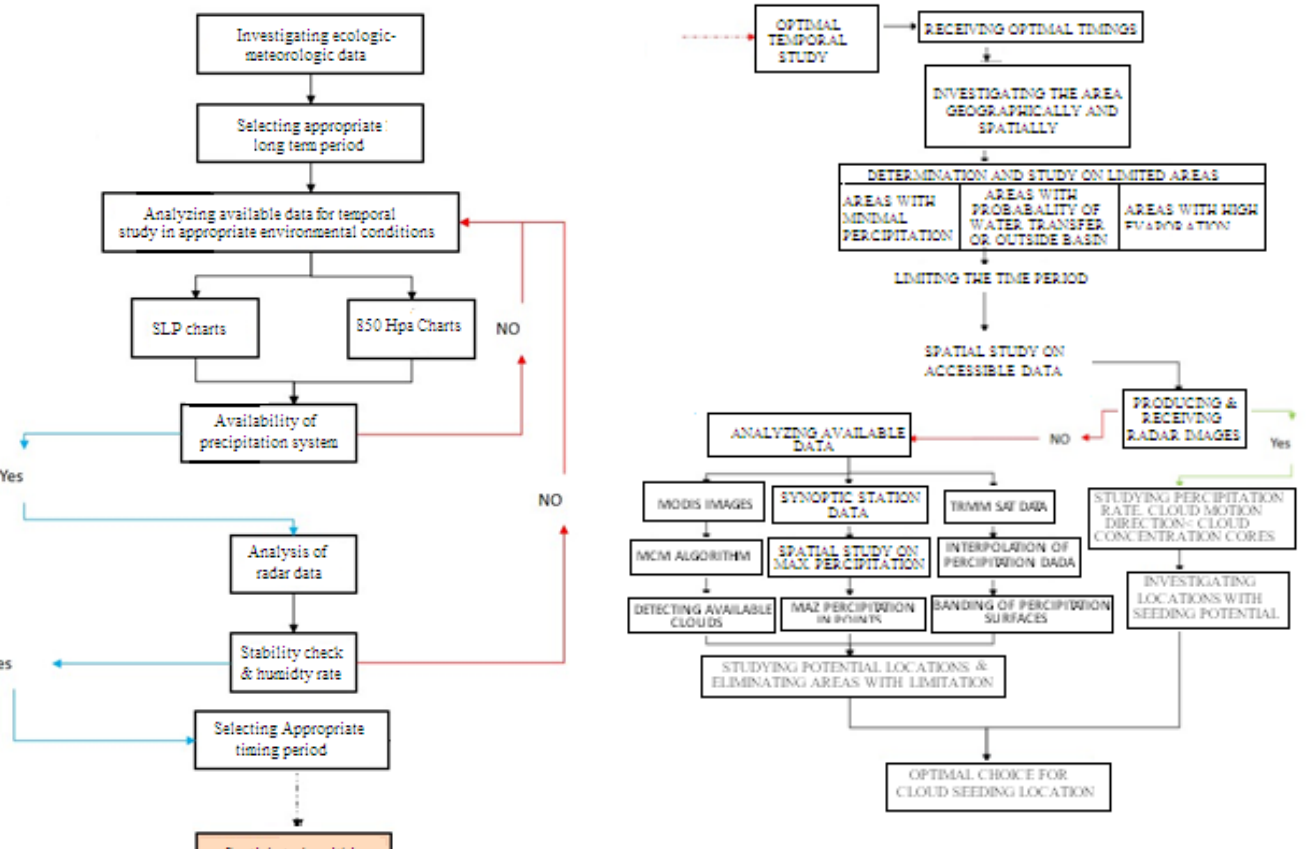
Figure 7: Algorithm for spatial study of cloud seeding